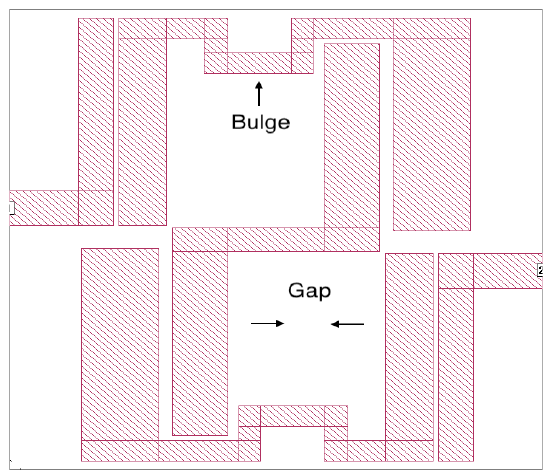
Figure 1. Design of the dual band pass filter